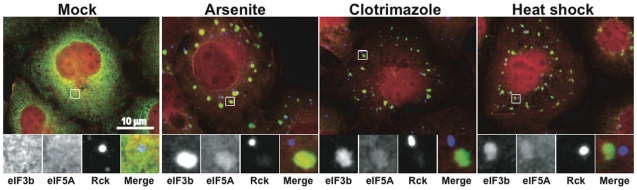
eIF5A is concentrated at SGs.COS7 cells were treated with sodium arsenite (0.5 mM), clotrimazole (20 µM) or heat shock (44°C) for 1 hour prior to processing for immunofluorescence microscopy using antibodies reactive with eIF3b (green, SG marker), Rck (blue, PB marker), and eIF5A (red). Enlarged views of boxed areas show individual channels and merged views.